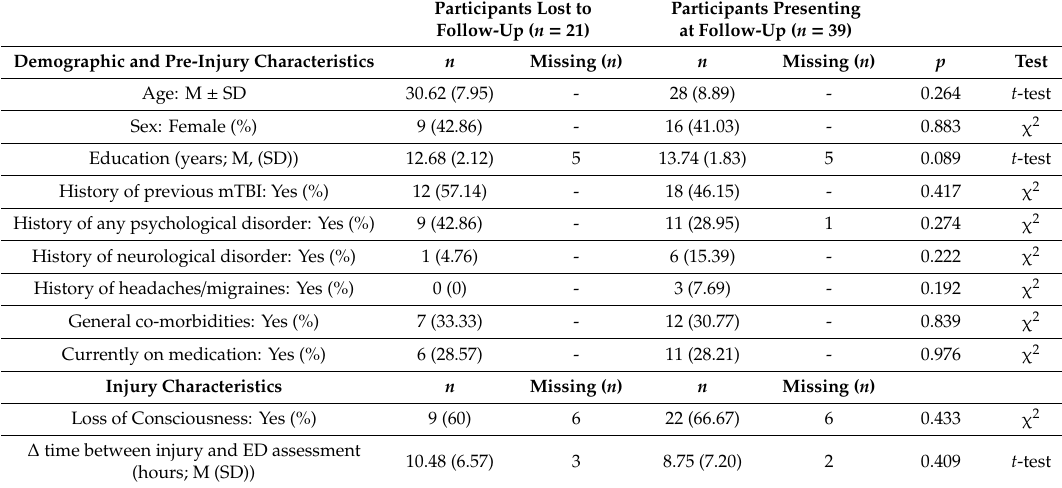
Figure 1. Consort diagram of study sample. Table 1. Characteristics of participants included in the study and those lost to follow-up. Participants Lost to Follow-Up ( n =